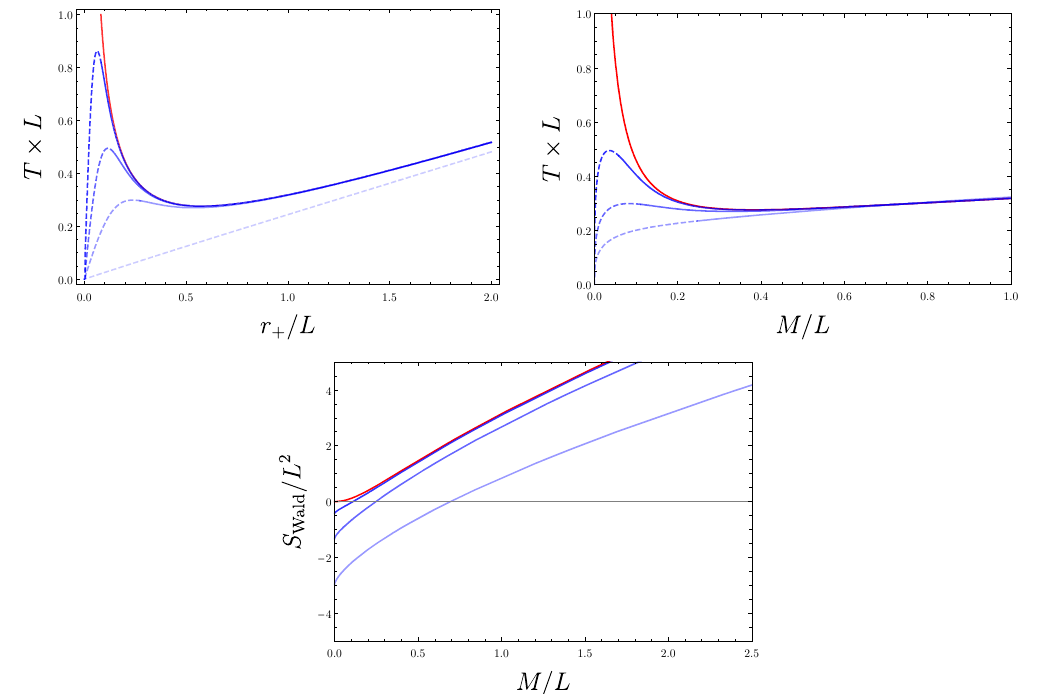
Figure 2 . Properties of four-dimensional uncharged black holes . Top Left : a plot of temperature vs. horizon radius for the four-dimensional spherical black holes. The red curve represents the Einstein gravity case, while the blue curves correspond to different values of the coupling µ/µ = c 1 / 1000 , 1 / 100 , 1 / 10, with curves of lower opacity corresponding to larger values of µ . The dashed portions of the curves indicate that the Wald entropy of the black holes is negative. Top Right : a similar plot, this time showing the temperature against the mass. Bottom Center : here we plot the Wald entropy against the black hole mass. The red curve corresponds to the Einstein gravity case, while the blue curves correspond to different, non-zero values of the coupling µ/µ = c 1 / 100 , 1 / 10 , 1 / 2, with curves of lower opacity corresponding to larger values of µ . We see that for any non-zero µ , the Wald entropy is negative as M →